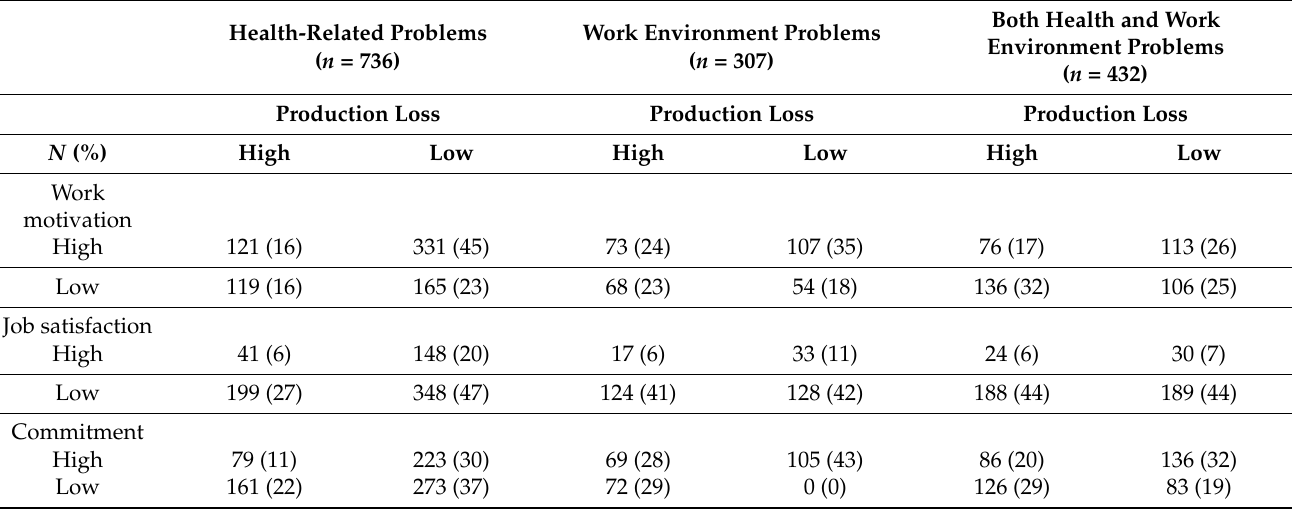
Table 4. Proportion of employees with high/low attitudes towards work and high/low levels of production loss, presented for the groups with different